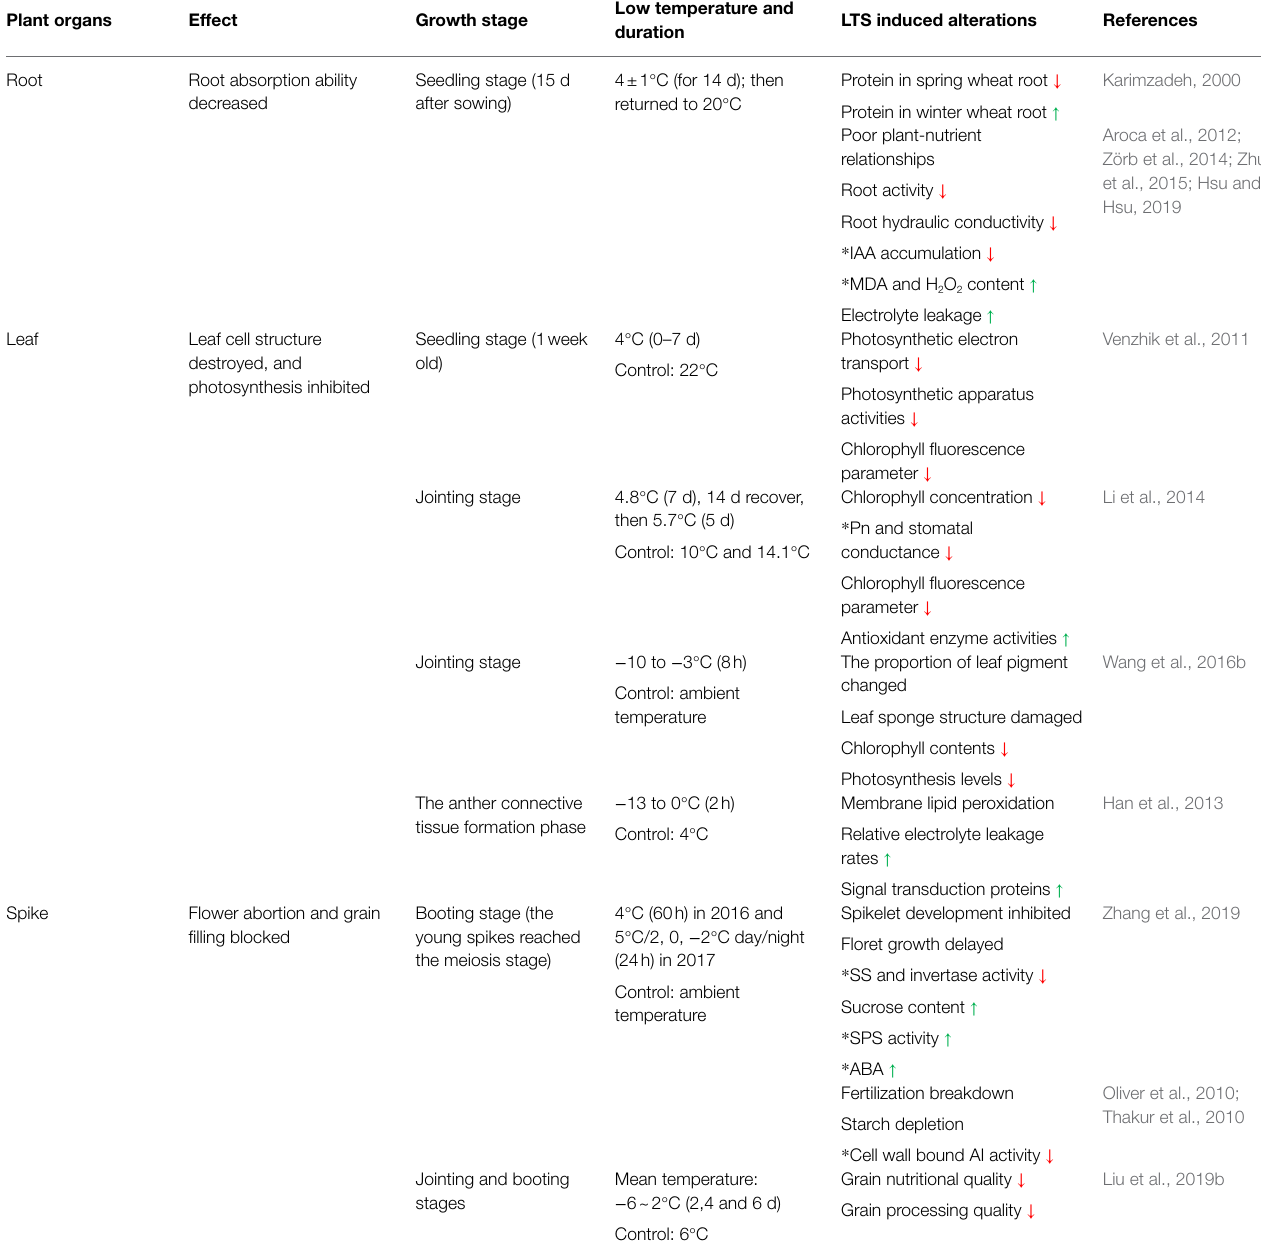
TABLE 3 | Physiological and biochemical traits of source-sink organs of wheat, influenced by